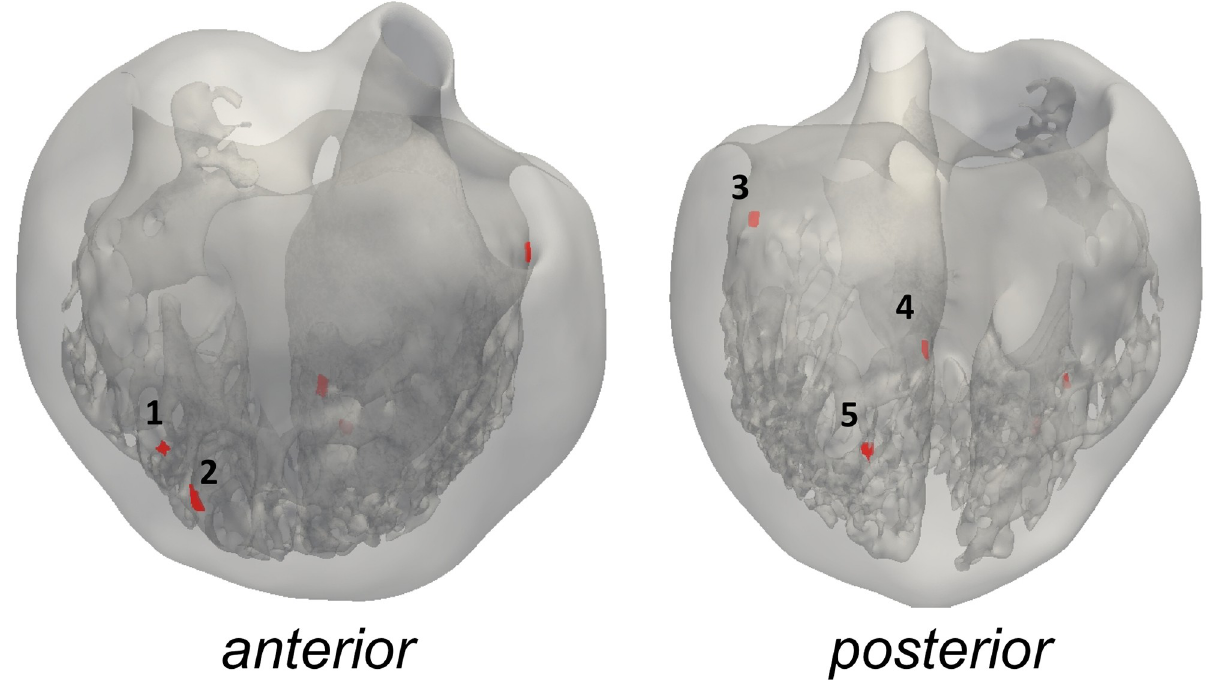
Fig 4. Anterior and posterior view of the geometry C with activation points. Points 1–2 are right ventricular IARs, 3–5—left ventricular IARs).